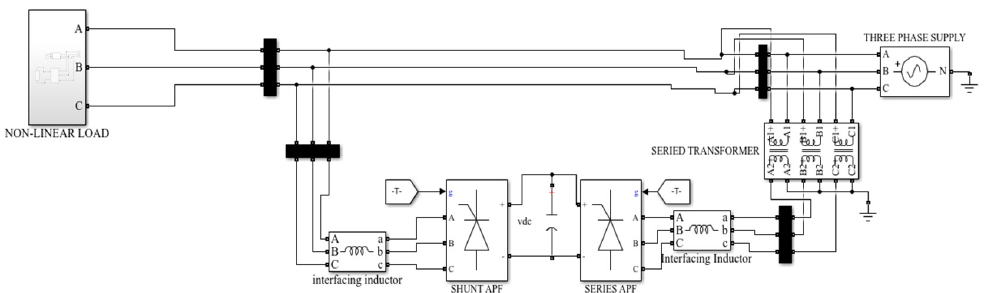
Figure 15. MATLAB Simulink